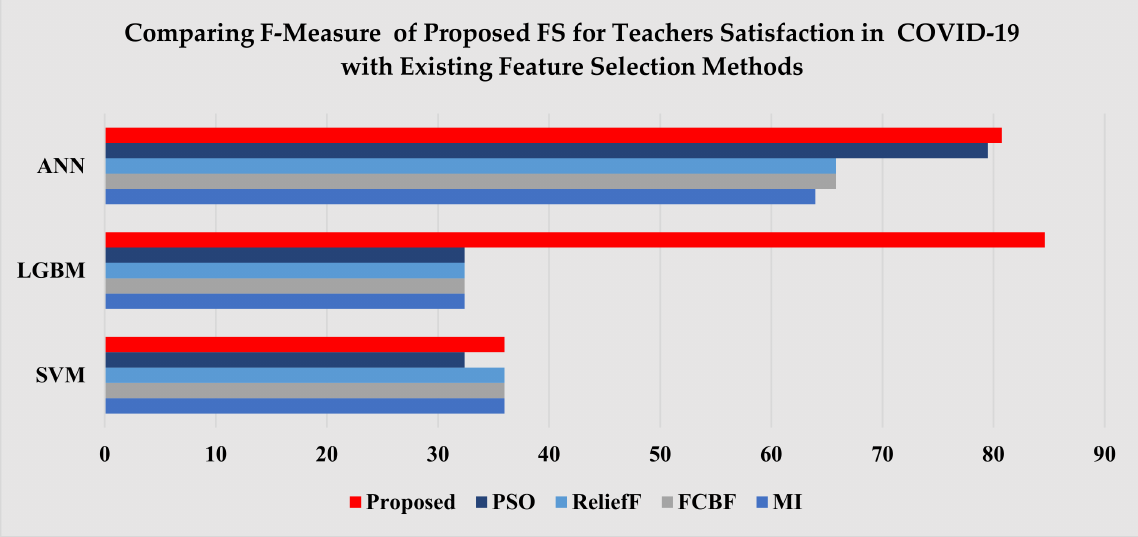
Figure 6. F-Measure Comparison of Proposed FS for Teachers Satisfaction in COVID-19 with Existing Feature Selection